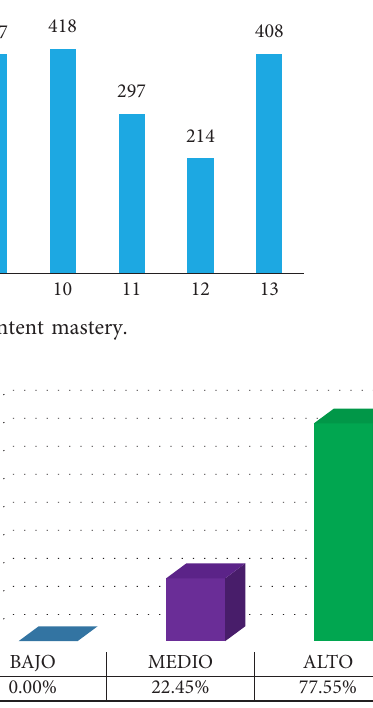
Figure 7: Category III: use of the platform, search for information, use of resources, and language proficiency and decision-making: